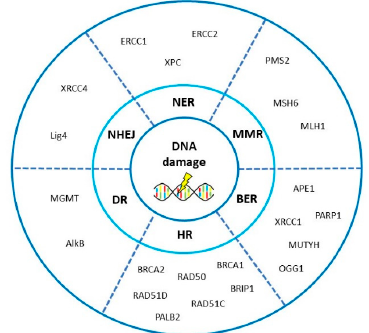
Figure 9. The most important genes involved in DNA repair pathways in ovarian cancer. Scheme of DNA damage and the most important genes playing role in ovarian carcinogenesis, prognosis and therapy response NER (nucleotide excision repair), BER (base excision repair), NHEJ (non-homologous end-joining repair), MMR (mismatch repair), HR (homologous recombination), DR (direct repair)). Protein names: PMS1 homolog 2 (PMS2), MutS homolog 6 (MSH6), MutL homolog 1 (MLH1), apurinic / apyrimidinic endonuclease 1 (APE1), poly(ADP-ribose) polymerase 1 (PARP1), X-ray repair cross-complementing 1 (XRCC1), MutY DNA glycosylase (MUTYH), 8-oxoguanine DNA glycosylase 1 (OGG1), breast cancer 1 and 2 (BRCA1 and 2), BRCA1-interacting protein C-terminal helicase (BRIP1), RAD50 homolog 1 (RAD50), RAD51 paralog C and paralog D (RAD51C and D), partner and localizer of BRCA2 (PALB2), alpha-ketoglutarate-dependent dioxygenase AlkB (AlkB), O 6 -methylguanine DNA methyltransferase (MGMT), DNA ligase 4 (LIG4), X-ray repair cross-complementing 4 (XRCC4), excision repair cross-complementation group 1 (ERCC1), xeroderma pigmentosum complementation protein C and D (XPC and D /